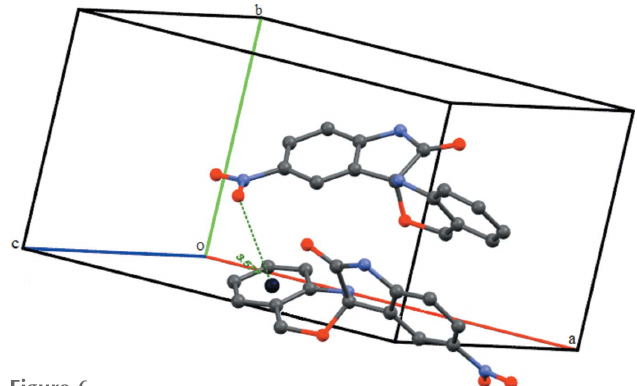
Figure 6 A partial view of the crystal packing of the title compound, showing the